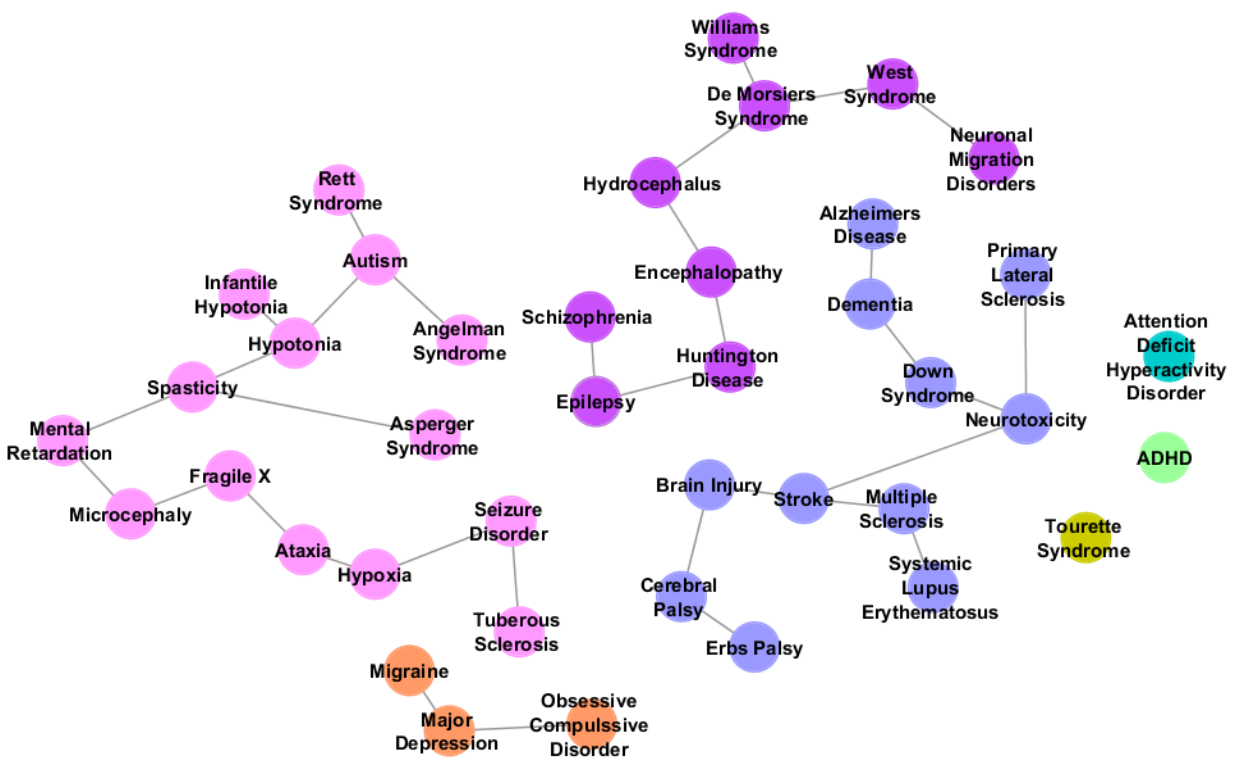
Figure 5. Neurological disorders related to autism listed by Autworks [35]. Different groups of colors represent disorder phylogeny. Nodes in pink refer to the autism sibling group, disorders that appeared to be most closely related to